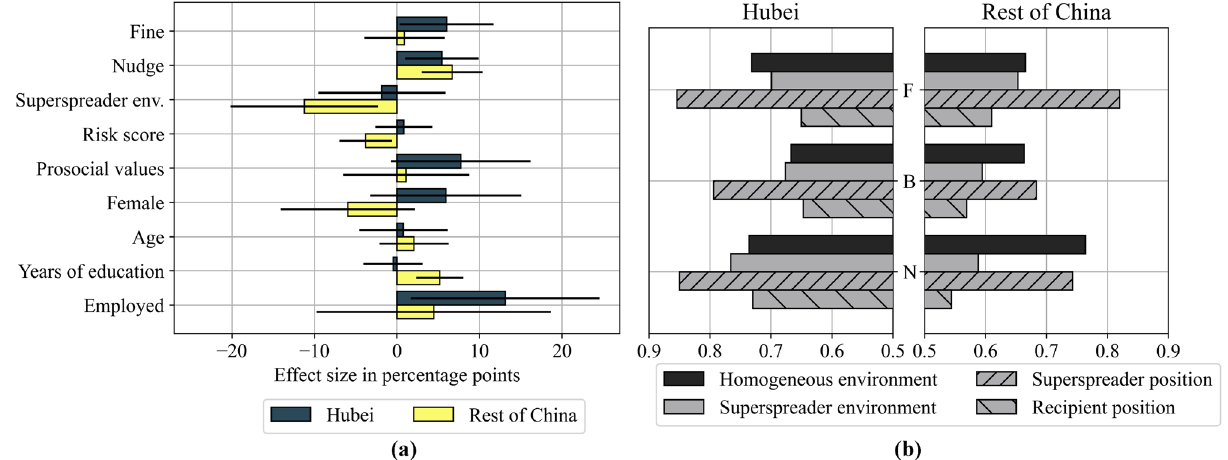
(2) Prosocial = 1 for subjects with prosocial values as classified by the SVO scale, (3) Female = 1 for female subjects, (4) age estimates are reported for an extra 10 years, (5) Employed = 1 if subject is either employed or runs their own business. ( b ) Probability of doing social distancing separately for Hubei and rest of China in baseline part of the experiment (B), and under fine (F) and nudge (N) interventions split by social environment and positions in the superspreader